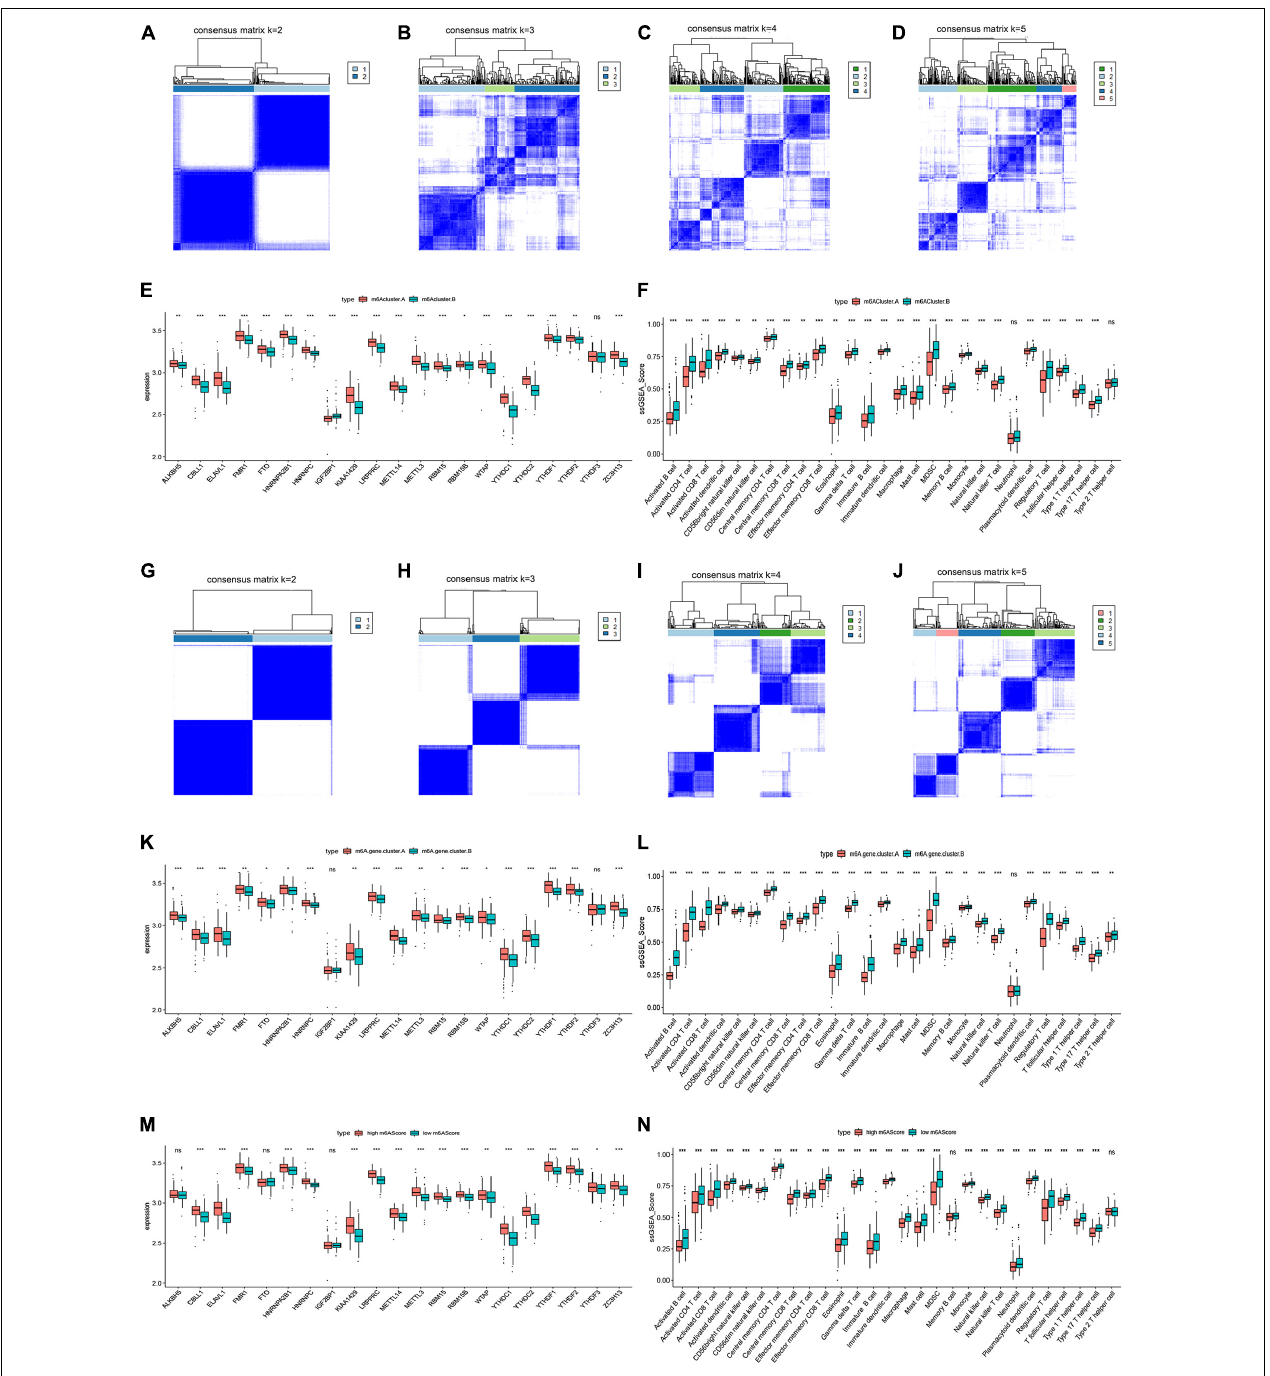
FIGURE 7 | Validation of the correlation between m6A regulators and immune microenvironment in ovarian cancer. (A–D) Consensus matrices of the 21 m6A regulators for k = 2–5. (E) Differential expression boxplot of the 21 m6A regulators in m6Acluster.A and m6Acluster.B. (F) Differential immune cell infiltration between m6Acluster.A and m6Acluster.B. (G–J) Consensus matrices of the 125 m6A-related genes for k = 2–5. (K) Differential expression boxplot of the 21 m6A regulators in m6A.gene.cluster.A and m6A.gene.cluster.B. (L) Differential immune cell infiltration between m6A.gene.cluster.A and m6A.gene.cluster.B. (M) Differential expression boxplot of the 21 m6A regulators in high and low m6A scores. (N) Differential immune cell infiltration between high and low m6A scores (* P < 0.05, ** P < 0.01, and *** P < 0.001).